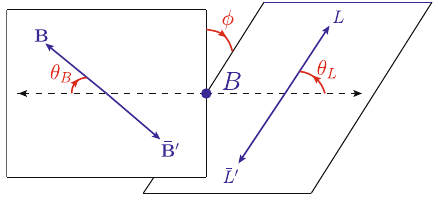
Fig. 3 The angular variables θ B , θ L and φ depicted for the four-body B → B ¯ B (cid:3) L ¯ L (cid:3) decays ¯ L (cid:3) ) system in the B meson rest frame. The angle φ is from ( L ¯ ¯ L (cid:3) plane defined by the momenta of B (cid:3) plane to the L the B ¯ ¯ L (cid:3) pair in the B meson rest frame, B (cid:3) pair and L the B